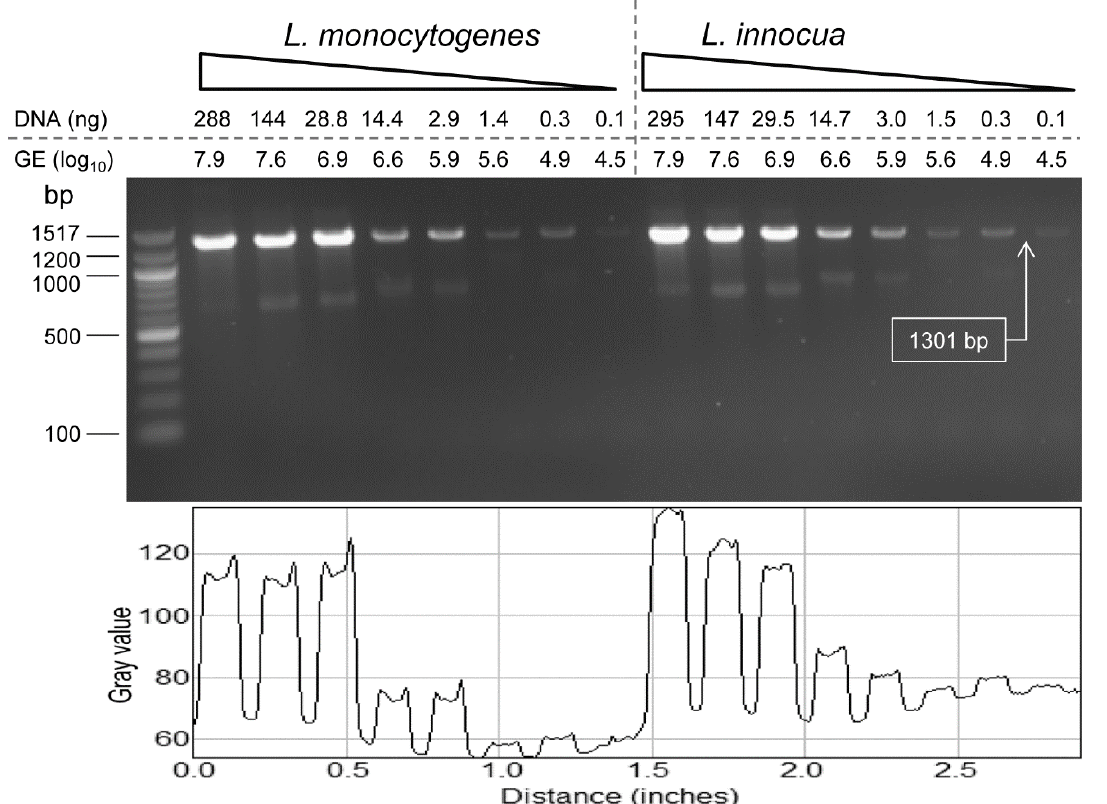
Figure 3. Sensitivity of lap gene-based Listeria species sensu stricto -specific primer (ELAP-F1/LIS-R1) tested against L. monocytogenes F4244 and L. innocua F4248.